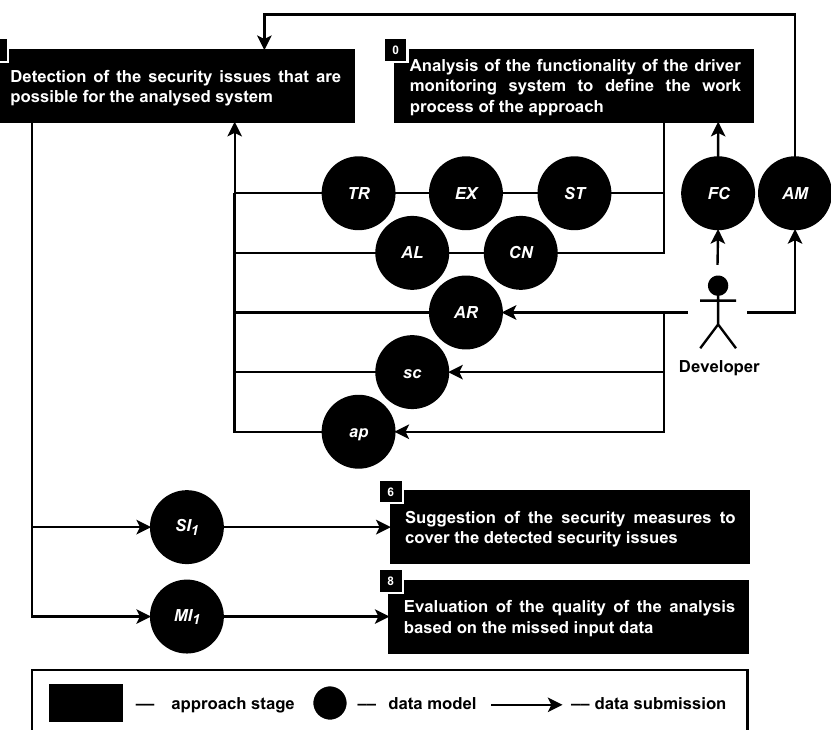
Figure 4. Stage 1—Detection of the possible security